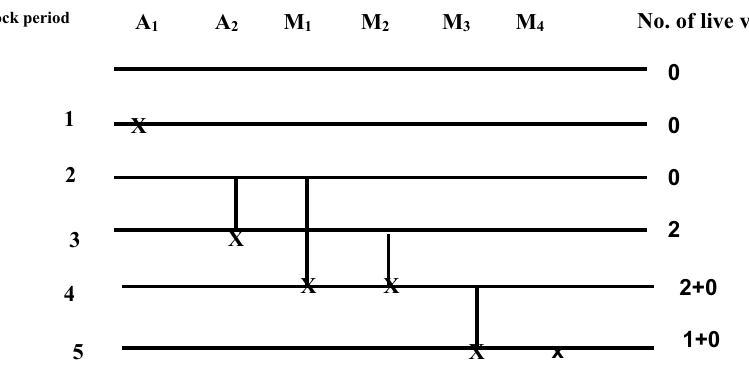
Figure 8. Lifetime chart of Block1.